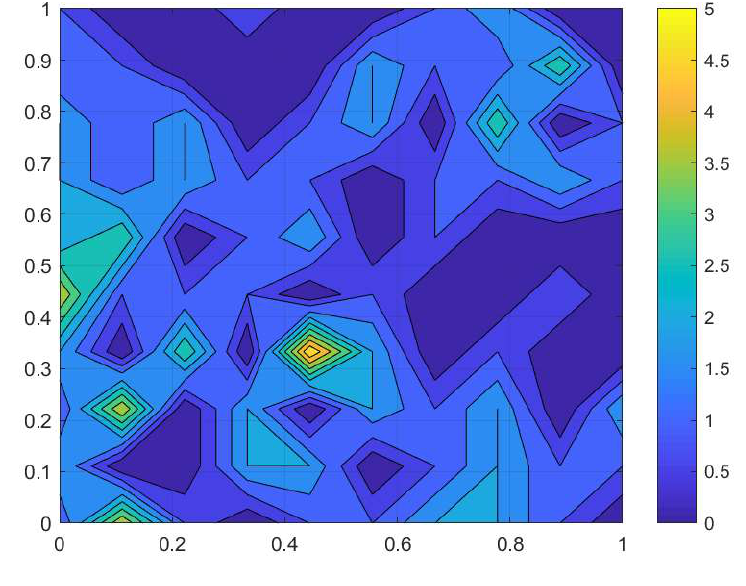
Figure 1. The slug spatial distribution reconstructed from trap counts. Trap counts were taken on a sampling grid of 10 × 10 locations in the Oadby field on 02 September 2016 (see details in the text), and the corresponding numerical values are given in Figure 2a. The total length L of the sampling grid (100 m) in the x and y directions is rescaled as L = 1. The continuous distribution shown in the figure was obtained from the discrete data (see Figure 2a) by using MATLAB